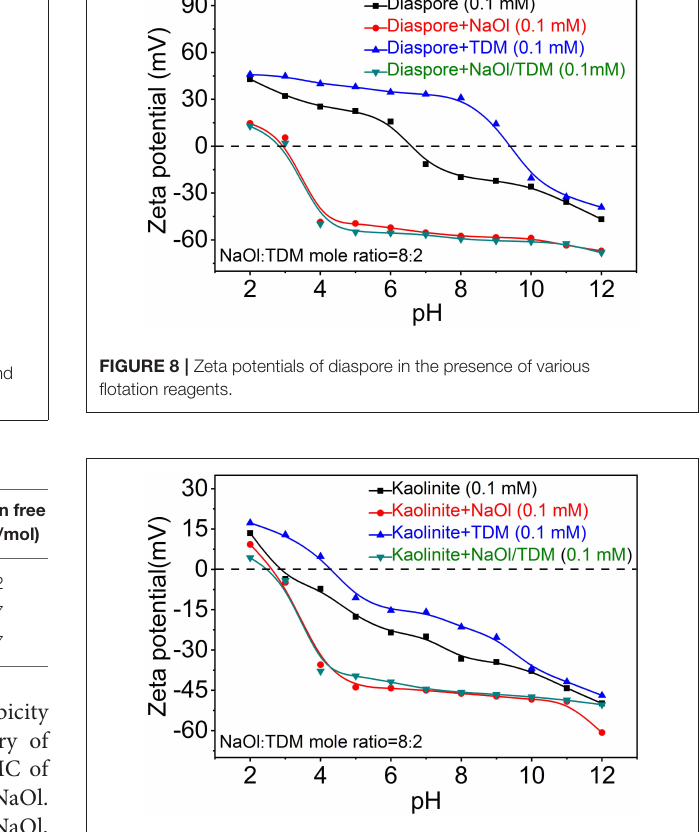
FIGURE 9 | Zeta potentials of diaspore in the presence of various flotation